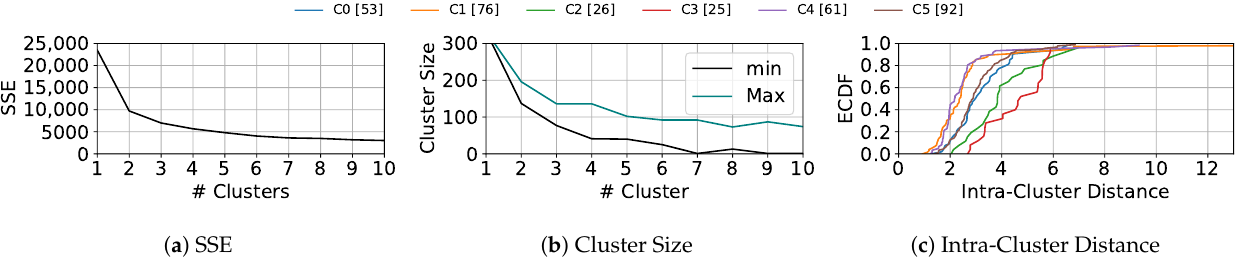
Figure 12. Cluster Metrics Working Station 1 Clamp 1 ws a .